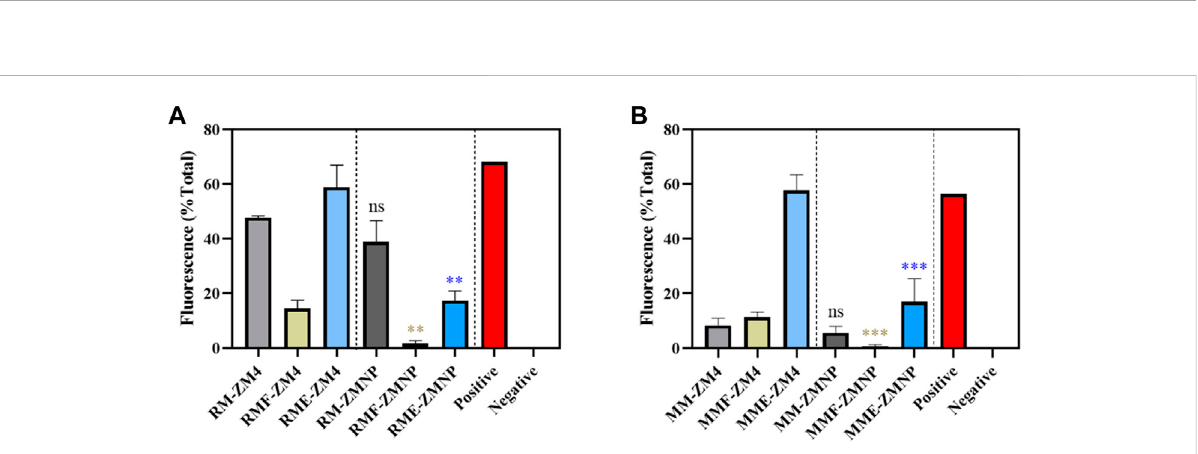
FIGURE 6 The ROS accumulation of ZM4 and ZMNP responding to different inhibitors. (A) ROS accumulation detection under RM with or without inhibitors. (B) ROS accumulation detection under MM with or without inhibitors. Data presented in the graphs are the mean ± SD of three replications. T-test analysis was conducted for ROS detection with RM/MM-ZM4 (black asterisk), RMF/MMF-ZM4 (green asterisk) or RME/MME (blue asterisk) condition as the control. ns represents no signi fi cant difference ( p -value > 0.05), * represents a signi fi cant difference (0.01 < p -value < 0.05), ** represents a signi fi cant difference (0.001 < p -value < 0.01), *** represents a signi fi cant difference ( p -value <